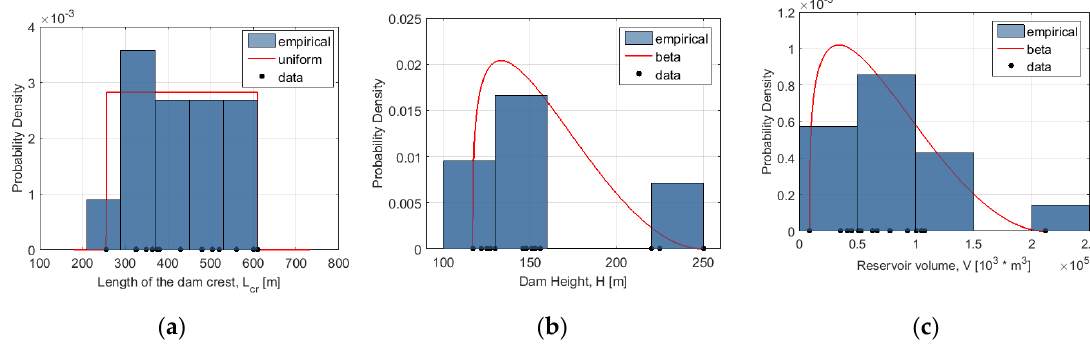
Figure 3. Marginal distributions for ( a ) length of the dam crest, L cr ; ( b ) dam height, H ; ( c ) reservoir volume, V .